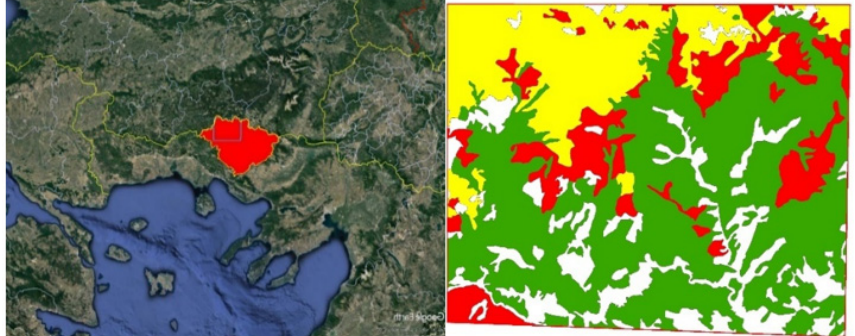
Figure 1. Drama prefecture ( left ) in red and the polygon where the methodology was applied in light blue (image from Google Earth). Main forest land use types ( right ) from CORINE. blue (image from Google Earth). Main forest land use types ( right ) from